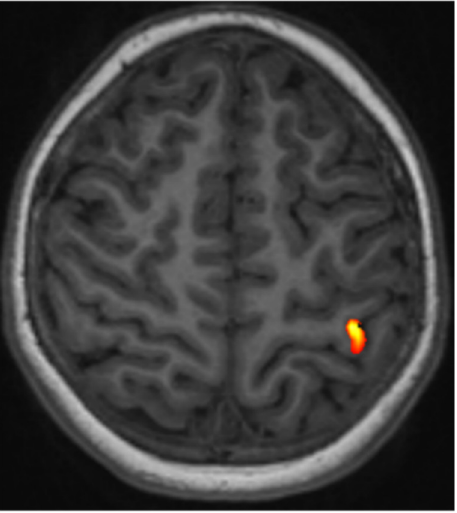
Figure 2. An exemplary fMRI of a healthy volunteer showing an intraparenchymal area of activation in the precentral gyrus (hand knob area).